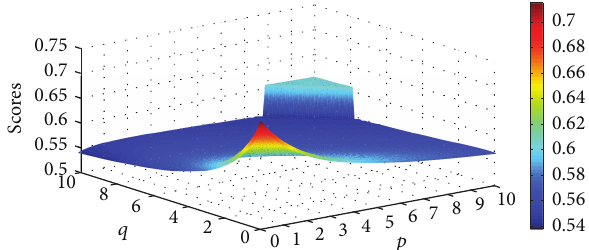
Figure 4: Scores of IIFGWHM ( 𝑞 = 1, 𝑝 ∈ (0, 10] ).